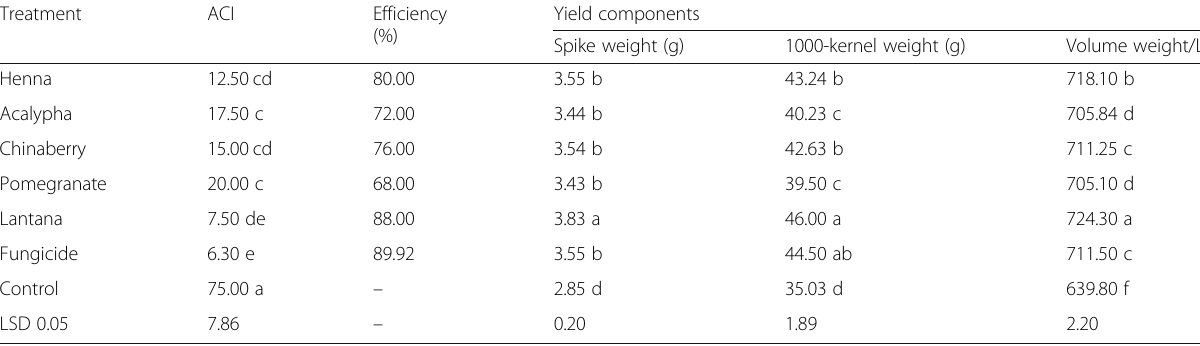
Table 1 Effect of the tested plant extracts on the average coefficients of infection (ACI) of wheat (cv. Gemmeiza-7) leaves by the leaf rust fungus, Puccinia triticina , and on the wheat yield components, under field conditions Treatment ACI Efficiency Yield components (%) Spike weight